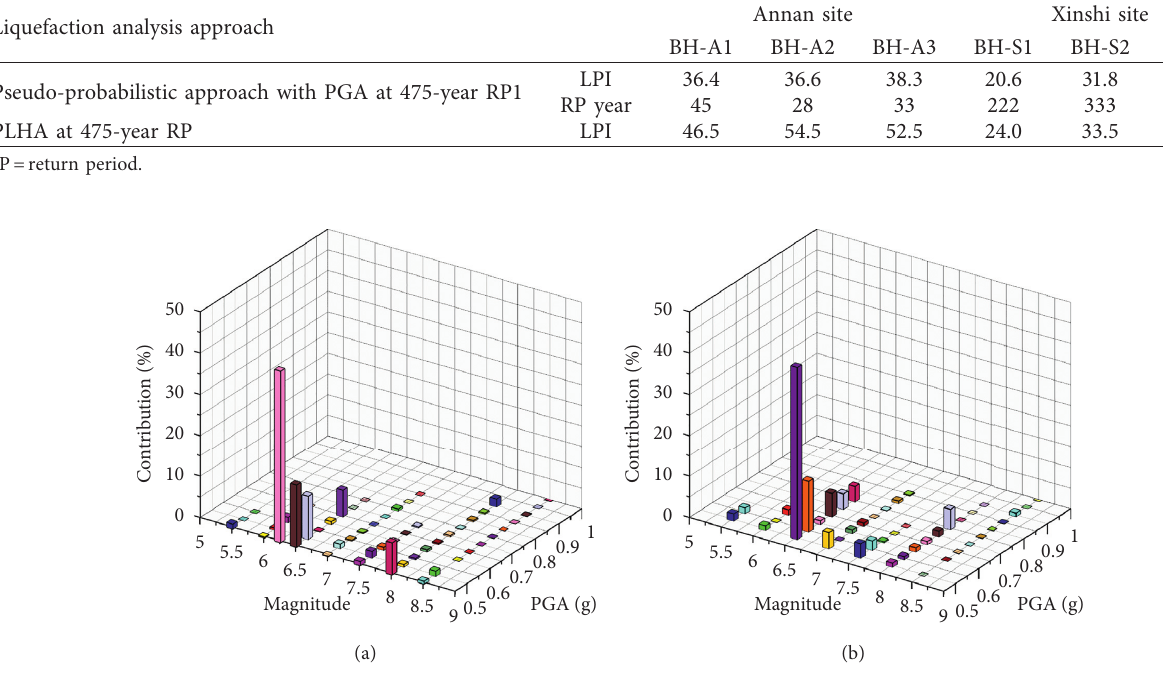
Figure 5: Deaggregation results of PGA at 475-year return period. (a) Annan site and (b) Xinshi